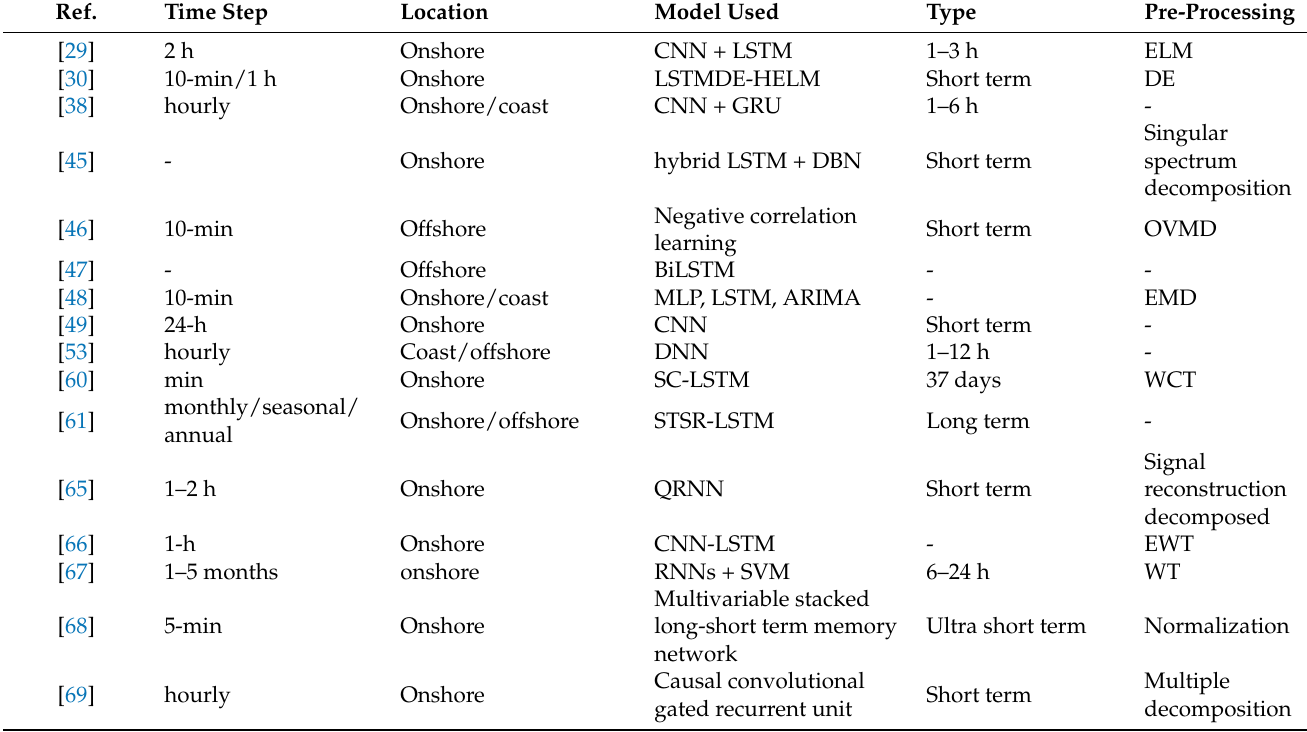
Table 3. Summary of wind speed forecasting models based on deep learning.